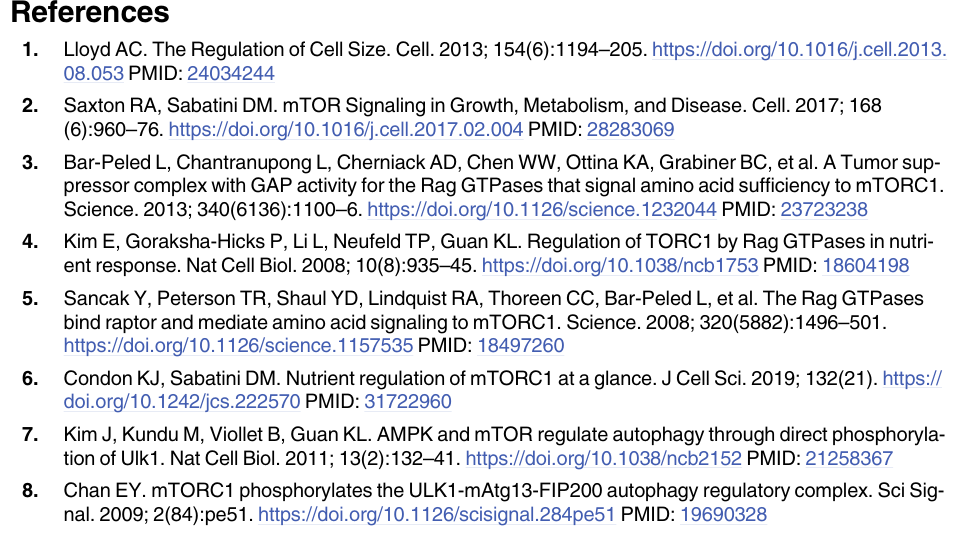
S1 Table. List of